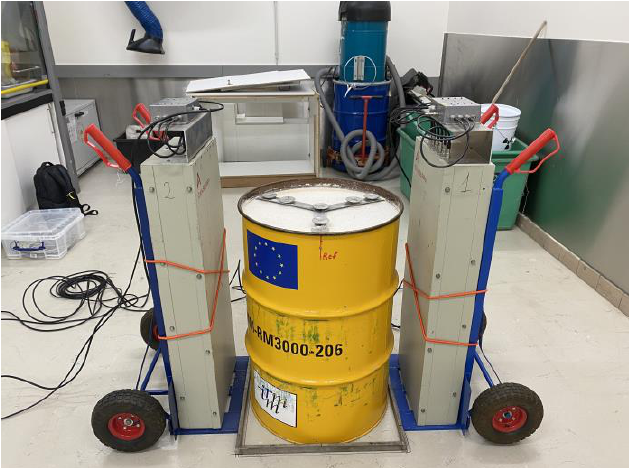
Figure 2: Picture of a measurement with the WM3400 slab counters and the ESARDA drum